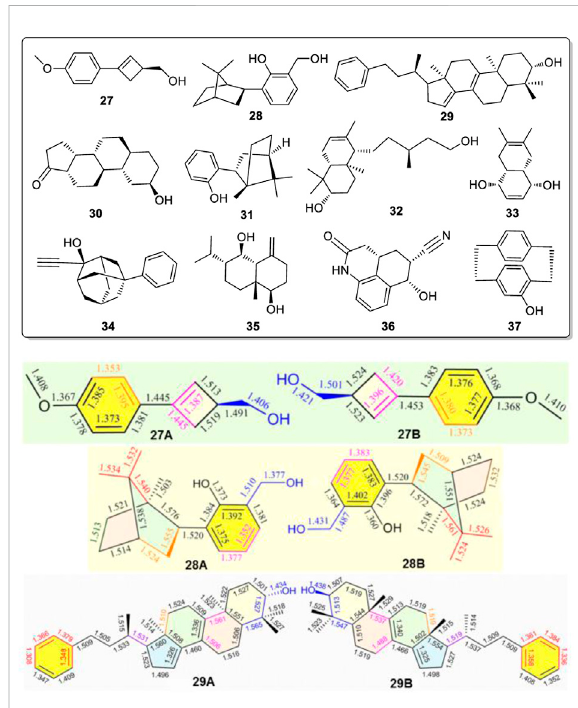
FIGURE 8 Compounds 27 - 37 all exist pseudo-resonance structures in the solid state. Typical geometric pairs with different solid state bond lengths for the corresponding bonds shown here for compounds 27 , 28 and 29 found co-existing in their single crystal